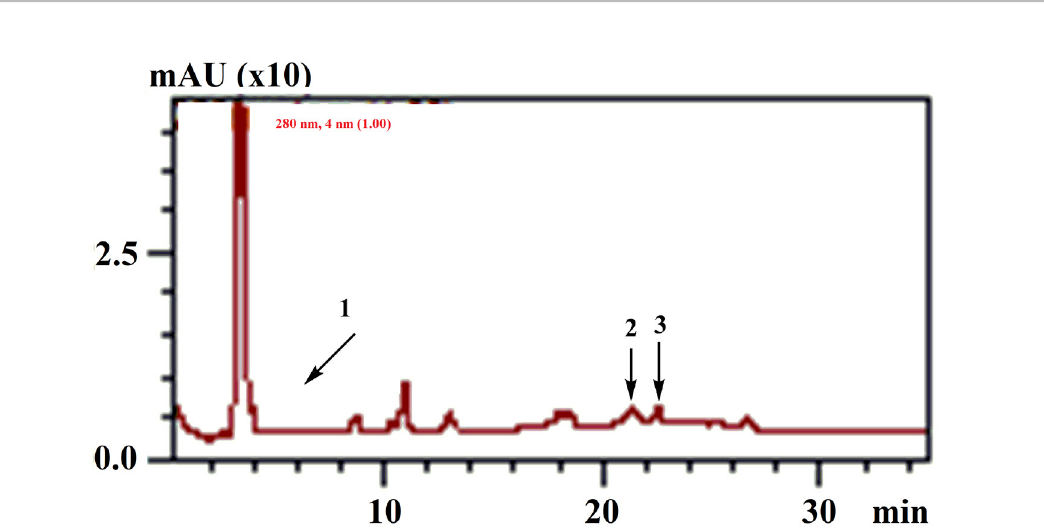
FIGURE 5 - HPLC chromatogram of L. annuus cotyledon water extract. The peaks correspond to: 1 gallic acid (280 nm wavelength); 2 epicatechin (260 nm wavelength); 3 caffeic acid (280 nm